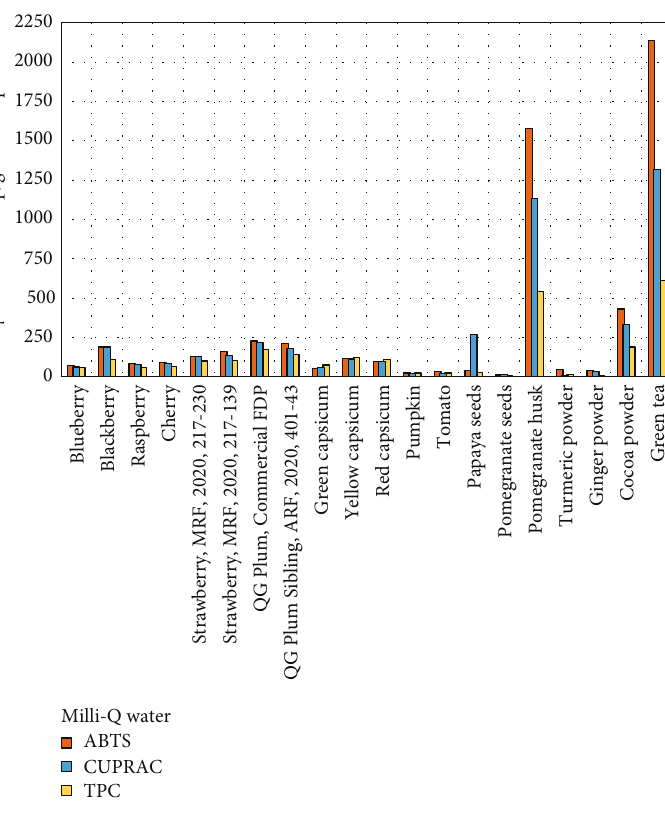
Figure 6: Comparison of ABTS, CUPRAC, and TPC assays in Milli-Q